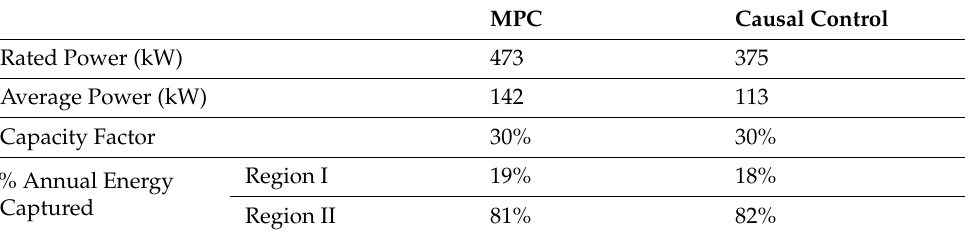
Table 3. Performance comparison of MPC and causal control for the DoE reference site at Humboldt Bay, CA, USA. MPC Causal Control Rated Power (kW) 473